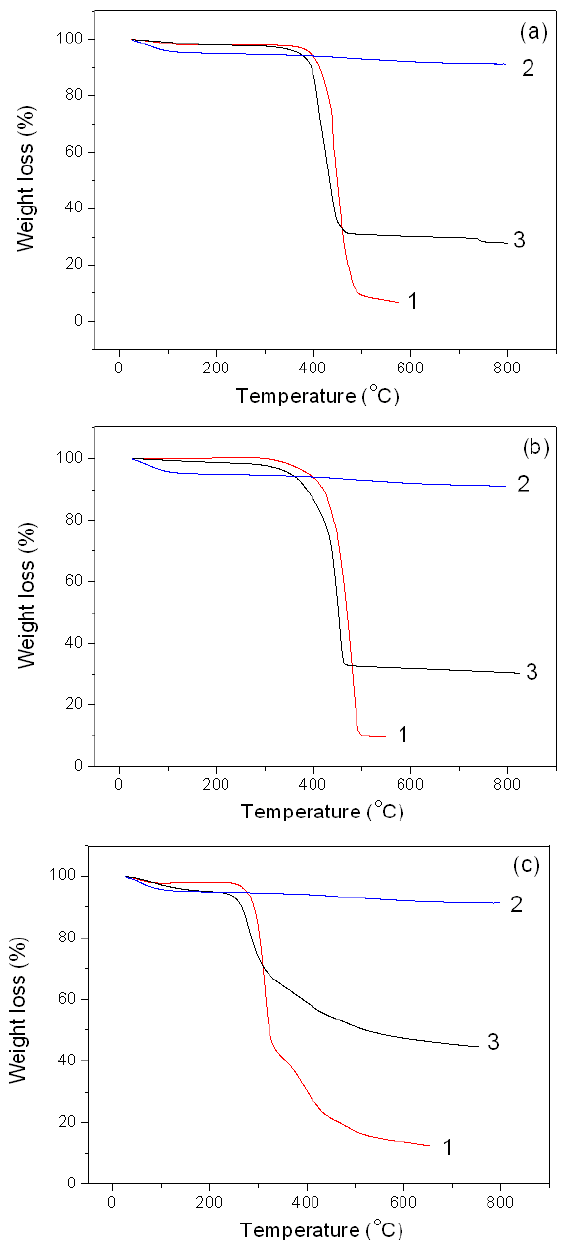
Figure 7. TG curves: ( a ) 1: BMImOTf, 2: MMT K10, and 3: MMT K10 / BMImOTf; ( b ) 1: BMImNTf 2 , 2: MMT K10, and 3: MMT K10 / BMImNTf 2 ; ( c ) 1: BMImDCA, 2: MMT K10, and 3: MMT K10 / BMImDCA.